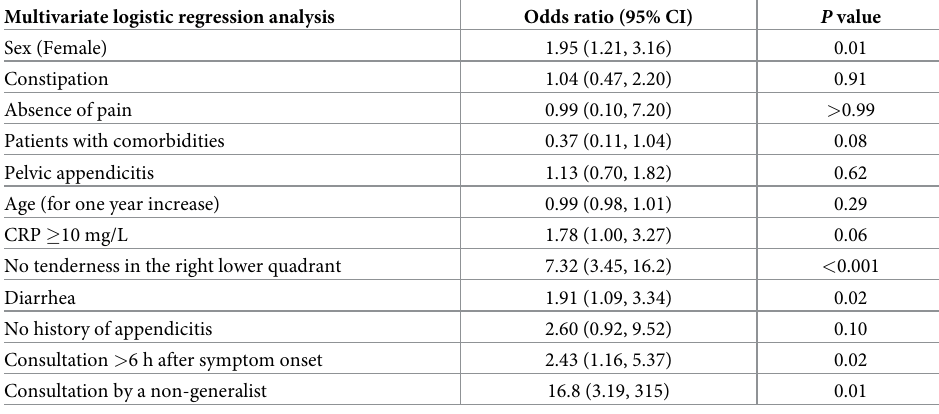
Table 2. Results of the multivariate logistic regression analysis to identify factors associated with a delayed diag- nosis of acute appendicitis. Multivariate logistic regression